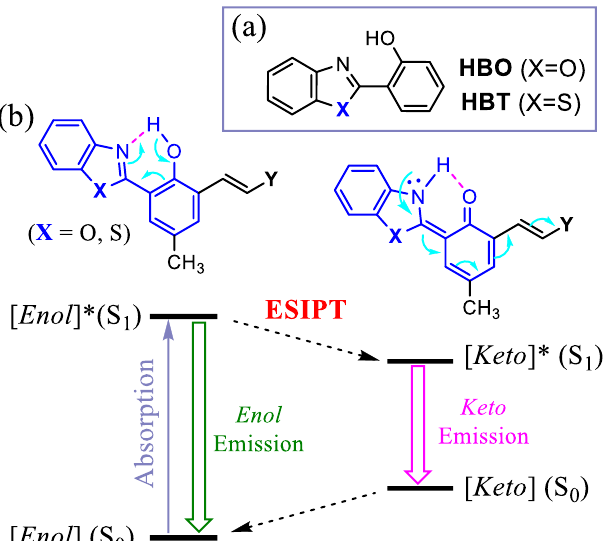
Figure 1. ( a ) Chemical structure of HBO and HBT. ( b ) Schematic illustration of the excited-state intramolecular proton transfer (ESIPT) process, where the asterisk indicates the excited state. After deactivation of the keto excited state (K*), a ground state retro proton transfer occurs to regenerate the enol form. In the illustration, the substituent “ Y ” represents an organic group, such as a pyridinium group in probe 1 .